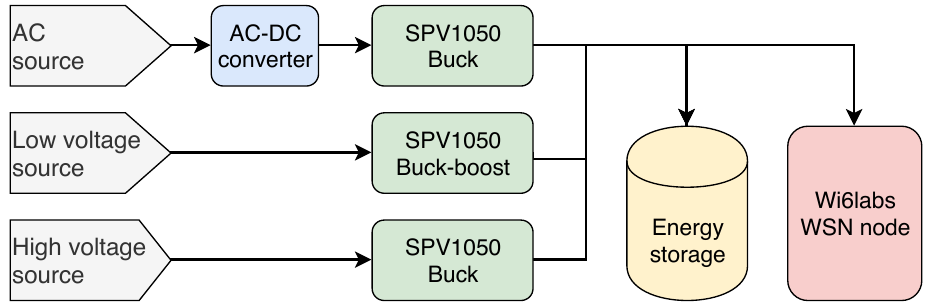
Figure 2. Architecture of the proposed multi-source energy-harvesting